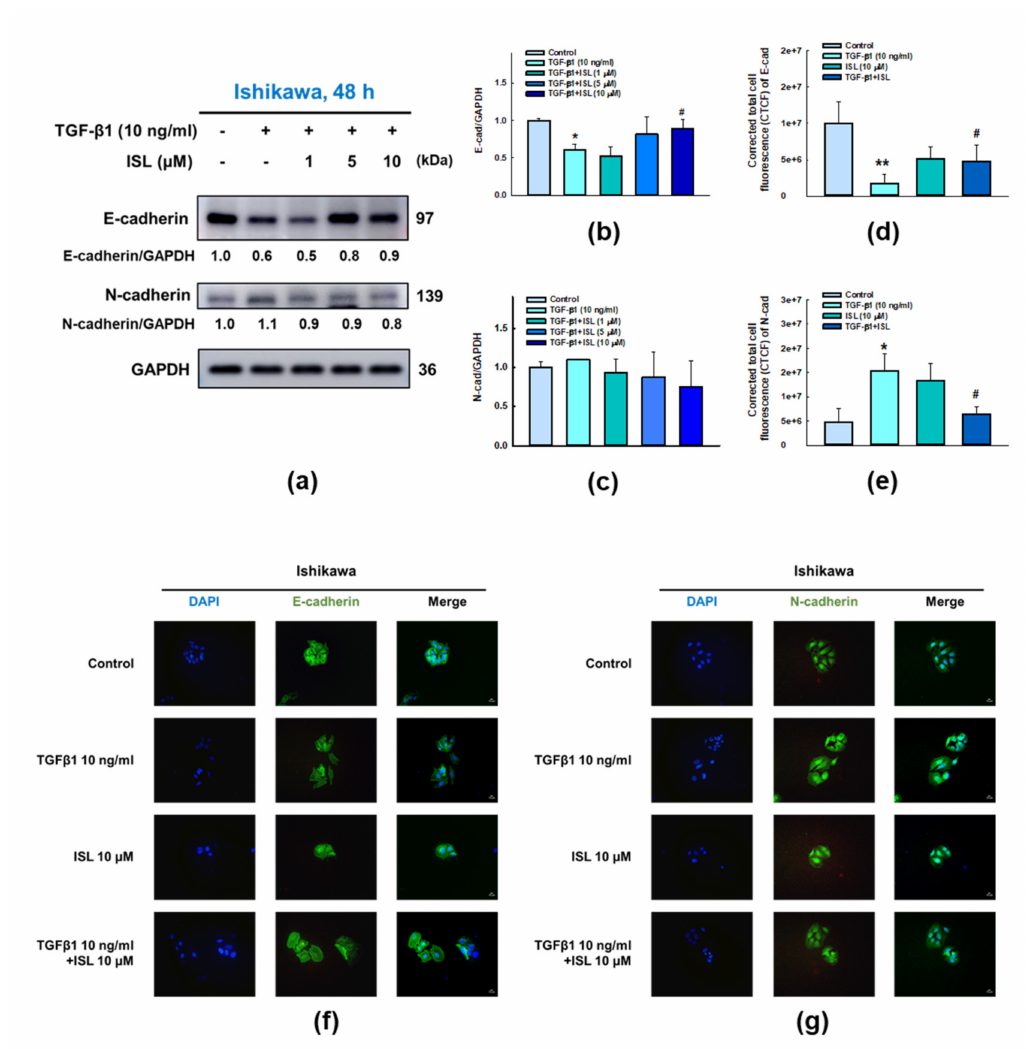
Figure 4. ISL reversed TGF- β 1-induced epithelial-mesenchymal transition (EMT) in human endometrial cancer Ishikawa cells. Cells were treated with 10 ng/mL of TGF- β 1 and ISL (1, 5, and 10 µ M) for 48 h. Cell lysates were separated by SDS- PAGE and subjected to western blotting with the anti-E-cadherin, and N-cadherin ( a ). Each target protein was normalized to GAPDH and protein quantification was shown in bar graph ( b , c ). Immunofluorescence staining in Ishikawa cells were monitored in the presence or absence of TGF- β 1 (10 ng/mL) and ISL (10 µ M). Green color represents the staining of E-cadherin ( f ) or N-cadherin ( g ). Blue color represents nuclear DNA staining by DAPI (600 × magnification). The corrected total cell fluorescence (CTCF) of E-cadherin ( d ) and N-cadherin ( e ) were quantified by ImageJ software. The quantitative values were expressed as the mean ± SD ( n = 3). * p < 0.05, ** p < 0.01 versus the vehicle control. # p < 0.05, versus the TGF- β 1 alone